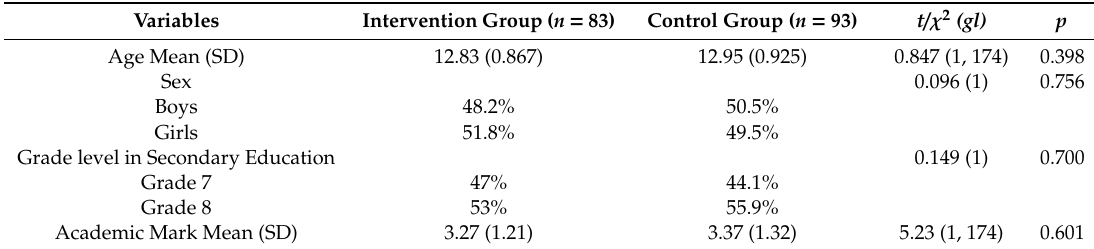
Table 2. Sample characteristics in intervention and control